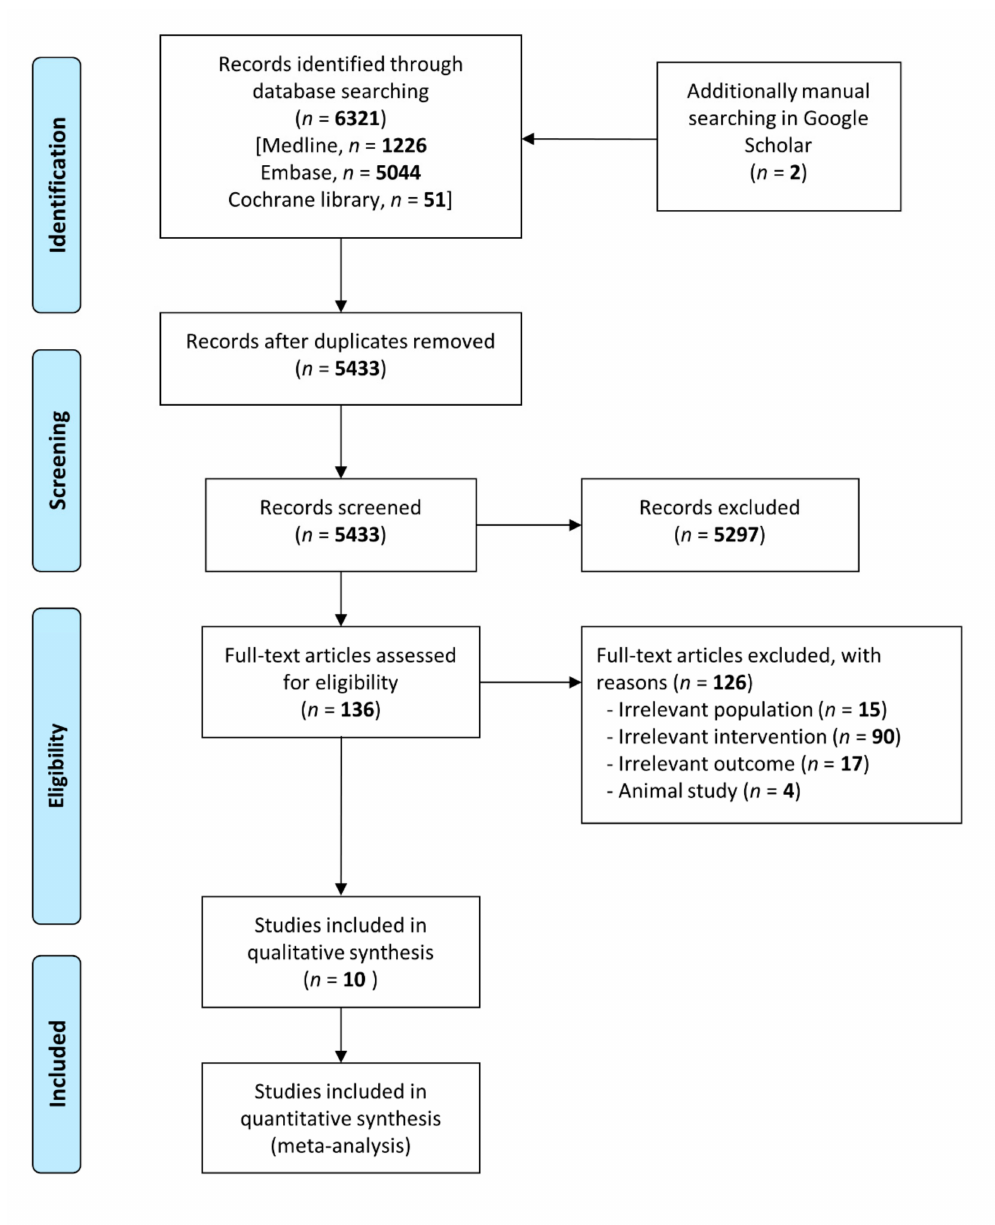
Figure 1. Flow diagram for identification of relevant